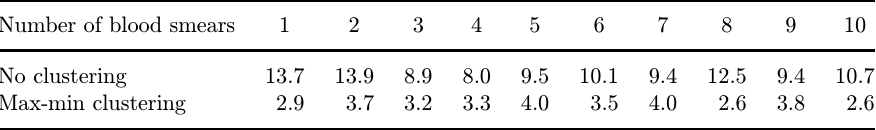
Table 1. One of the 10 medical professionals' time consumption recorded (unit: minute).